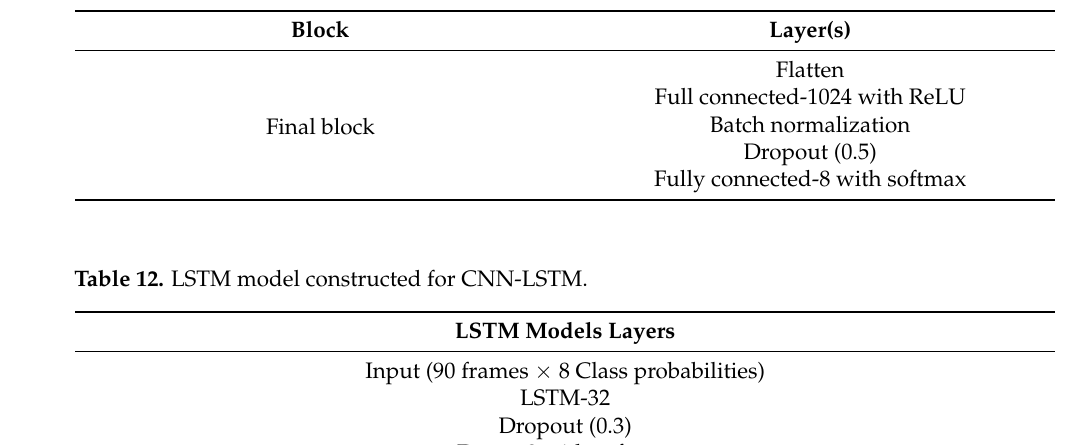
Table 11. The final block.